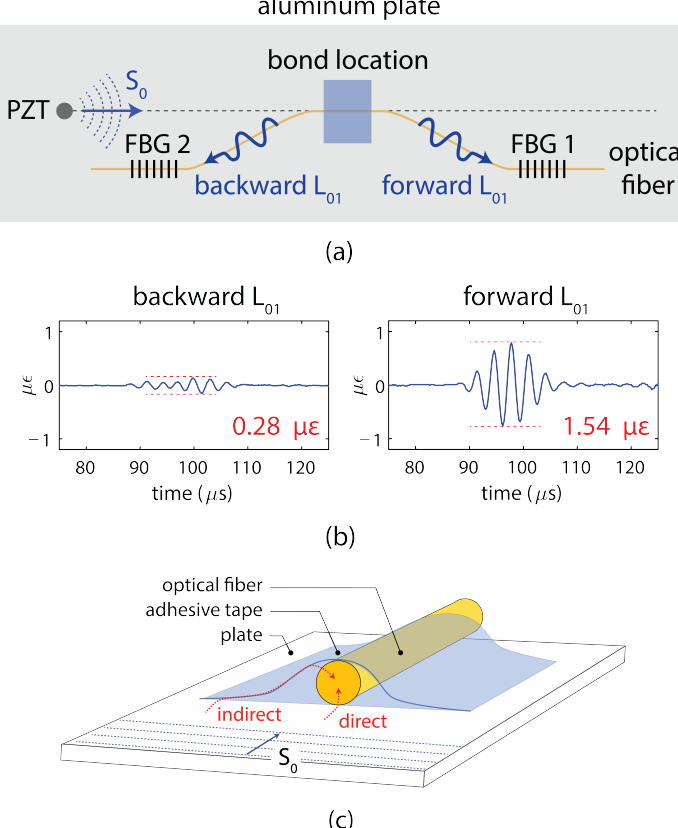
Figure 18. ( a ) Experiment and ( b ) measured forward and backward coupled L 01 modes for S 0 mode coupling to forward and backward L 01 modes for remotely bonded FBG. The bond is adhesive tape. Strain peak-to-peak amplitude is also given in each plot. ( c ) Schematic of indirect and direct ultrasonic pathways